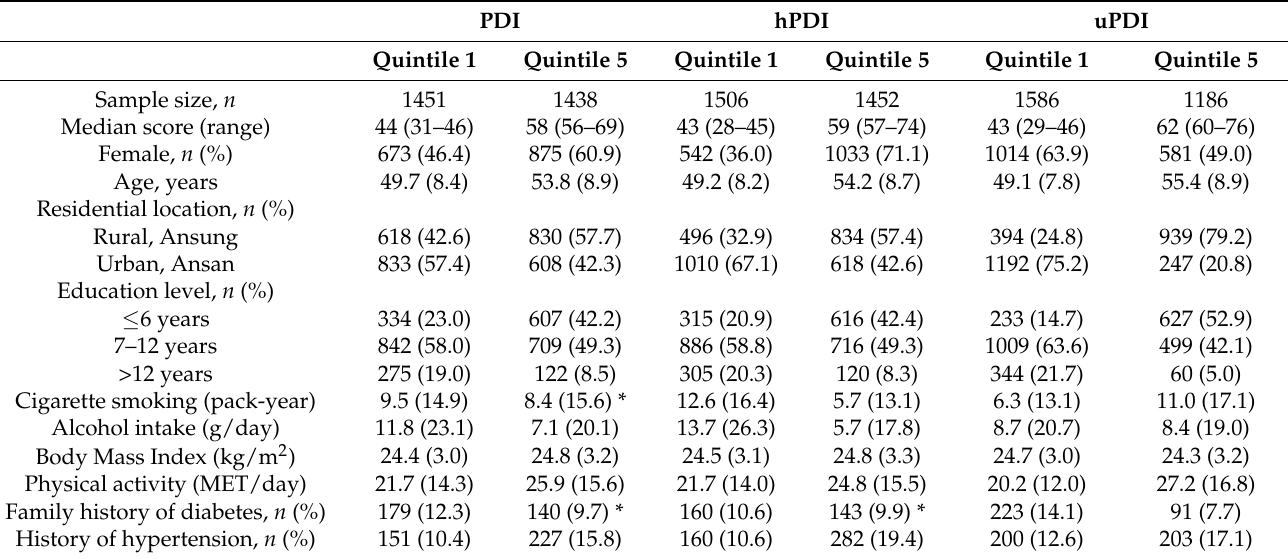
Table 1. Baseline characteristics of study participants in the lowest versus highest quintile of plant- based diet indices.